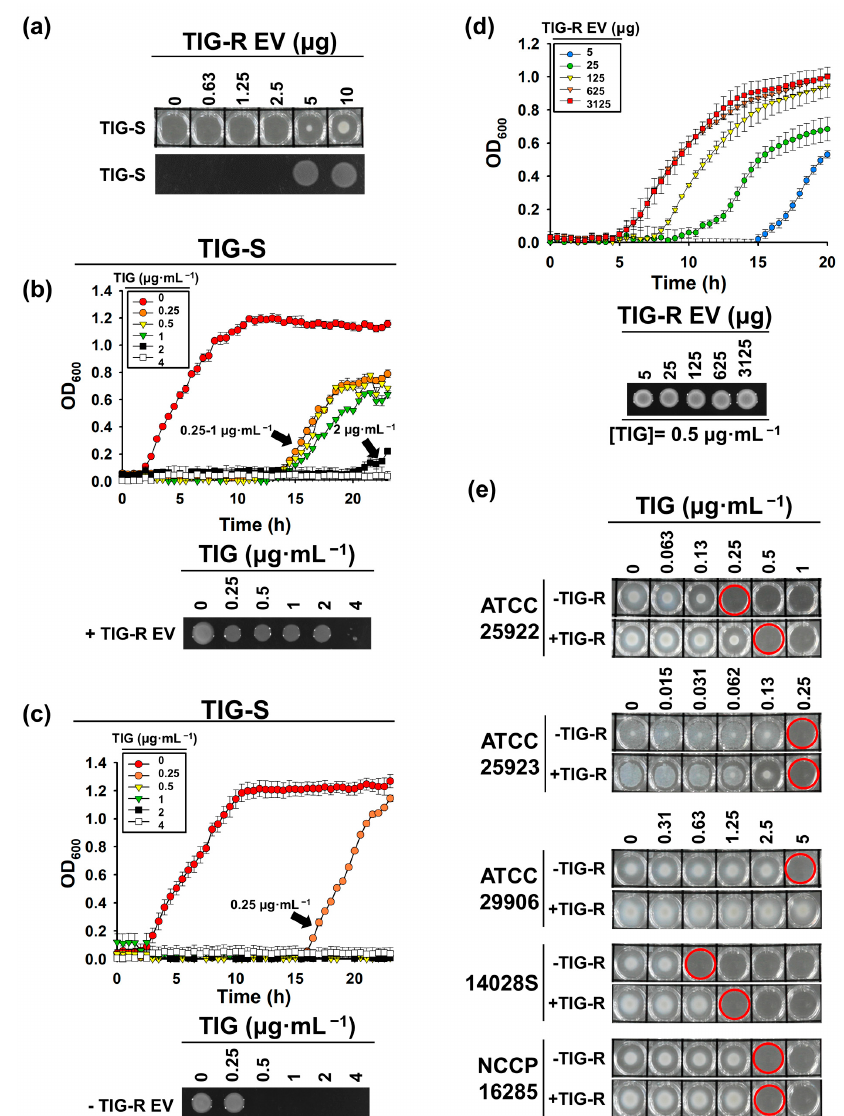
Figure 2. Transfer of TIG-R to AB and other bacterial strains. ( a ) Minimum amount of TIG-R EV inducing TIG-R against TIG-S (ATCC 17978) AB strain. Aliquots (5 µ L) treated with TIG-R EVs at indicated concentrations were spotted onto an LB-agar plate containing TIG at 0.5 µ g · mL − 1 and grown for 16 h. Over 5 µ g · mL − 1 of TIG-R EVs, bacterial cells survived on the LB-agar plate. Growth curve analysis of TIG-S AB (ATCC 17978) strain with ( b , Top) or without ( c , Top) TIG-R EVs (5 µ g) under different concentrations of TIG (0–4 µ g · mL − 1 ) was performed to evaluate the transfer activity. ( b , c , Bottom) Cell viability. Aliquots (5 µ L) of cells from ( b , Top) and ( c , Bottom) were spotted onto LB-agar plates and grown for 16 h. LB-agar plates were imaged by ChemiDoc TM MP Imaging System (Bio-Rad, Hercules, CA, USA) and Image Lab Software (ver.5.2.1, Bio-Rad, Hercules, CA, USA). Error bars in growth curves indicate statistical significance at p < 0.05 (n = 3). ( d ) Dose-dependency of TIG resistance. Growth curve of TIG-S AB strain was conducted under TIG at 0.5 µ g · mL − 1 with increasing amounts of TIG-R EVs. Cells were grown at 37 ◦ C for 24 h with 500 rpm in 96-well microplates and growth was monitored by measuring the OD 600 using a SPECTROStar ® Nano (BMG LABTECH GmbH, Ortenberg, Germany, n = 3). ( e ) Transfer spectrum of TIG-R EVs. TIG MICs of E. coli (ATCC 25922), K. pneumoniae (NCCP 16285), P. mirabilis (ATCC 29906), S. aureus (ATCC 25923), and S. typhimurium (14028S) against TIG (0–5 µ g · mL − 1 ) without or with TIG-R EVs of 5 µ g was determined. One of the representative data from n = 3 was shown. The 96-well plates were imaged with a digital camera (Samsung NX200, Suwon, Korea). Red circles indicate MICs for individual